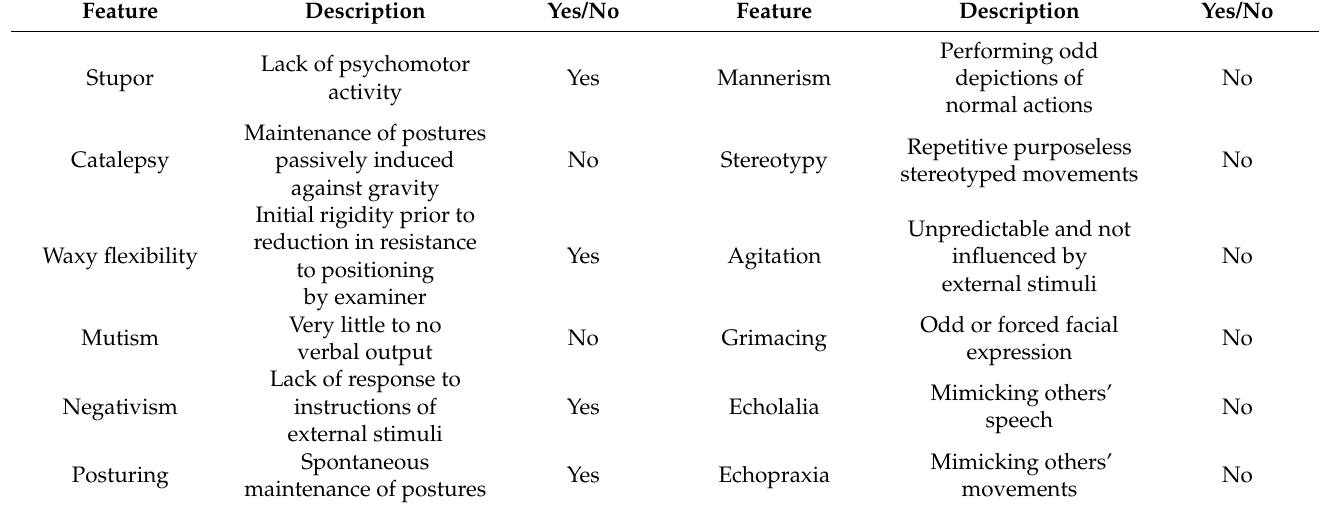
Table 1. DSM-V diagnostic criteria for catatonia. Patient was diagnosed with catatonia following their matching with 4 clinical features accompanied by at least 3 of the aforementioned